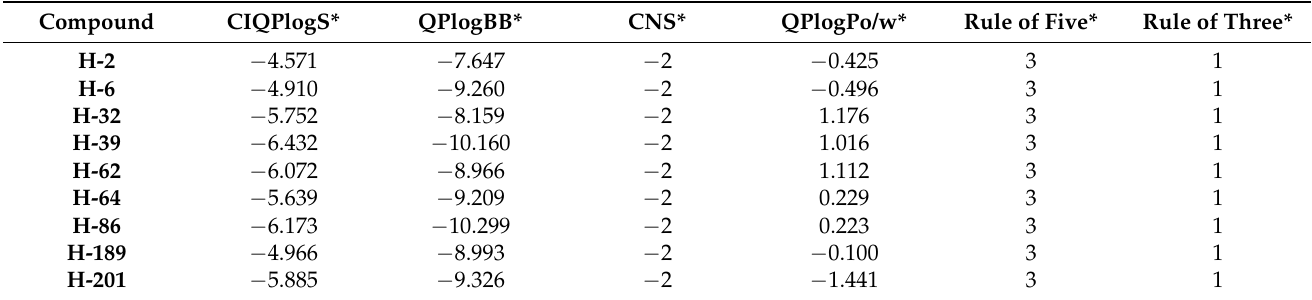
Table 4. Predicted ADME properties of new L-HIPPO